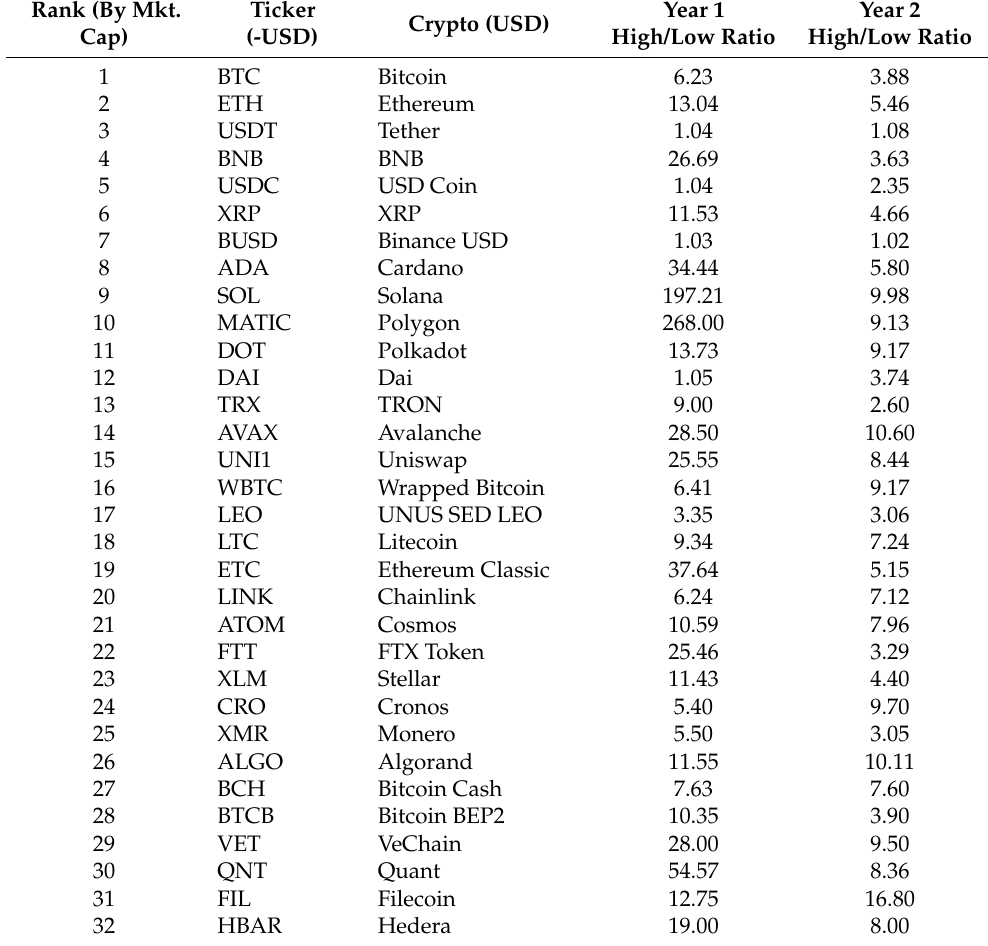
Table 4. Cryptocurrencies high/low